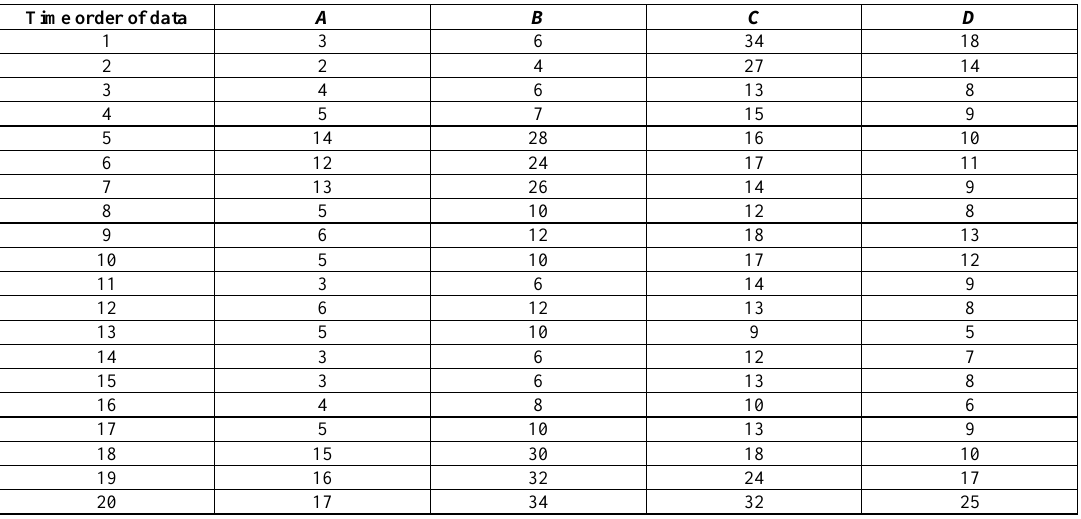
Table 1. Data of time series A , B , C &